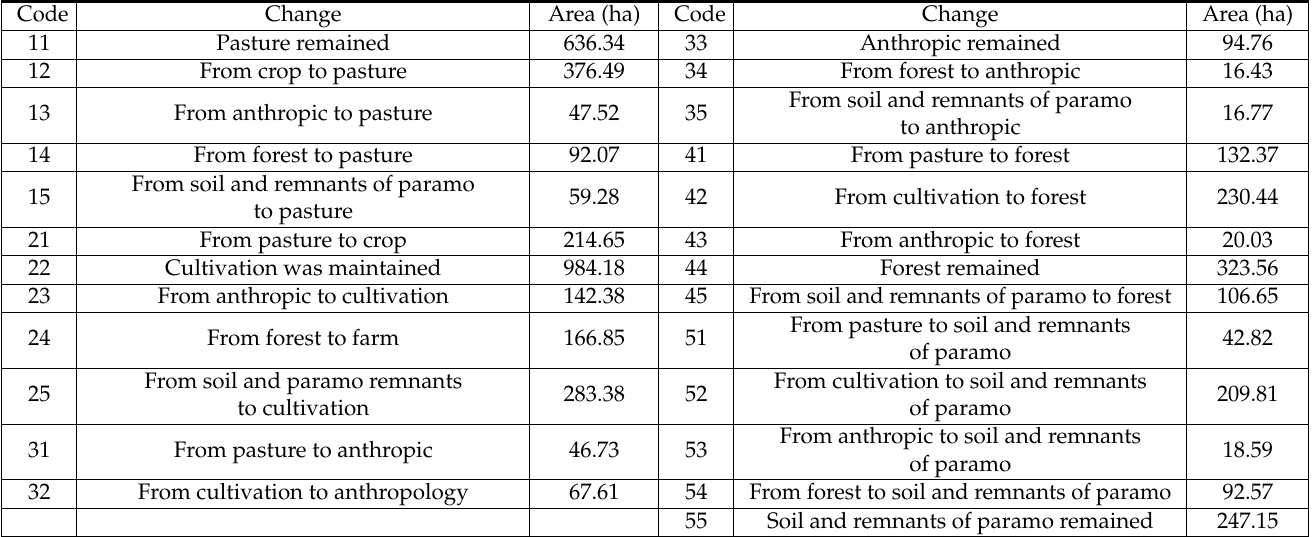
Figure 4. Losses and profits in the time interval 2009–2019. Regarding pasture cover, a higher percentage of gains (12.32%) than losses (9.35%) was observed, maintaining a trend similar to the previous period. In the forest category, in this period of time, it presented a higher percentage of the gains (10.48%) than the losses. The same occurred with anthropic coverage, quite the opposite of the previous period, where its percentage of losses (4.89%) was slightly higher than the percentage of gains (3.16%). The corresponding areas are presented in the Tables 8 and 9. Table 9. Coverage transitions in terms of area in the time interval